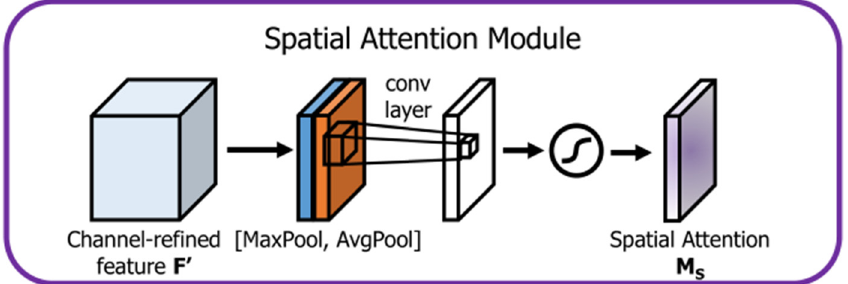
Figure 7. Spatial attention structure diagram.